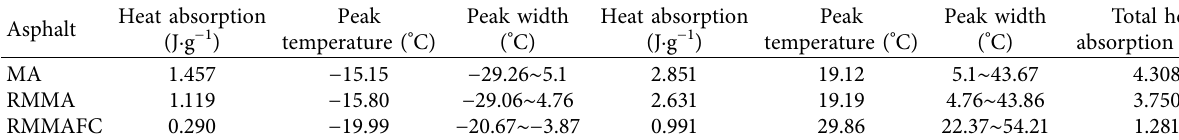
Table 4: Test results of state transition process of